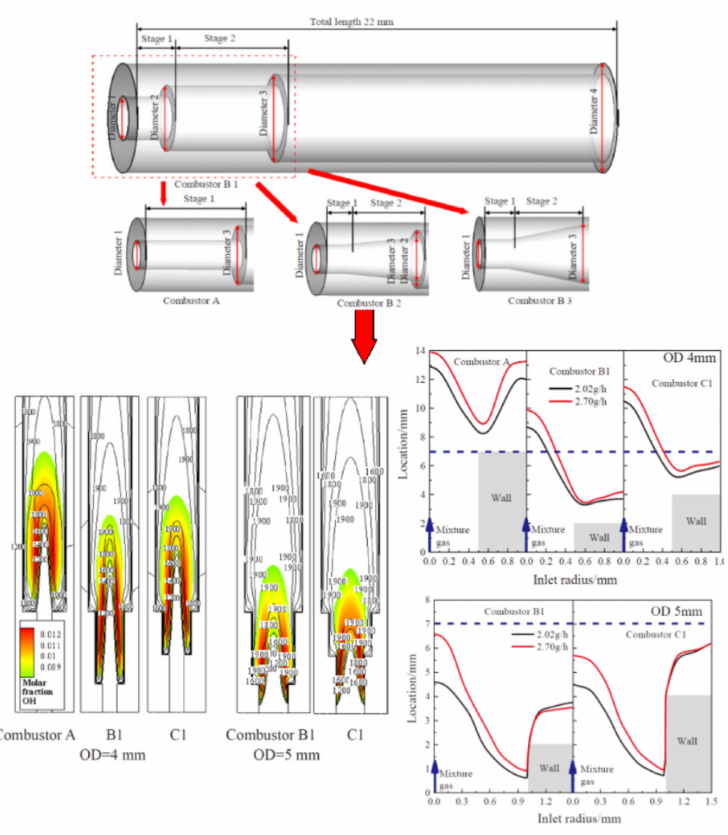
Figure 18. The effects of step length on temperature distribution and flame